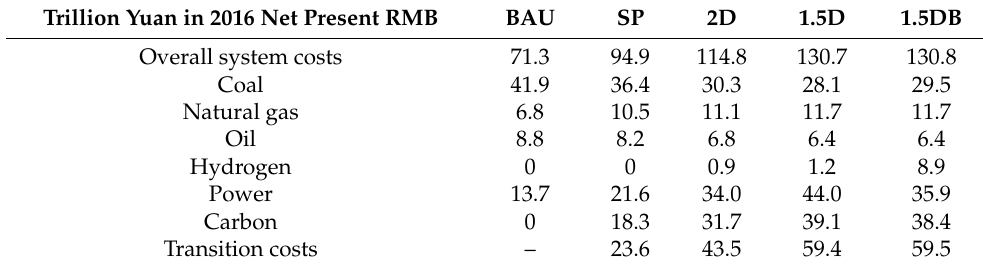
Table 3. Overall system costs and transition